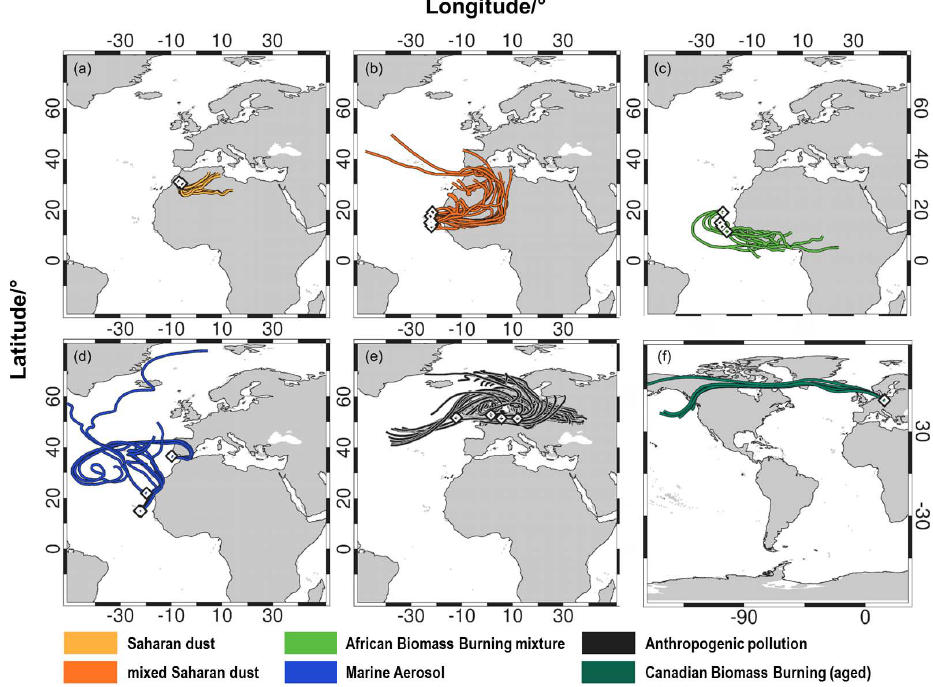
Fig. 3. Backward trajectories for the aerosol layers detected by HSRL measurements (Table 1) and of different origin observed during the LACE98, SAMUM-1, SAMUM-2 and EUCAARI field campaigns. Trajectories date back 5 days for (a) , (b) , (d) and (e) , and 7 days for (c) and (f)